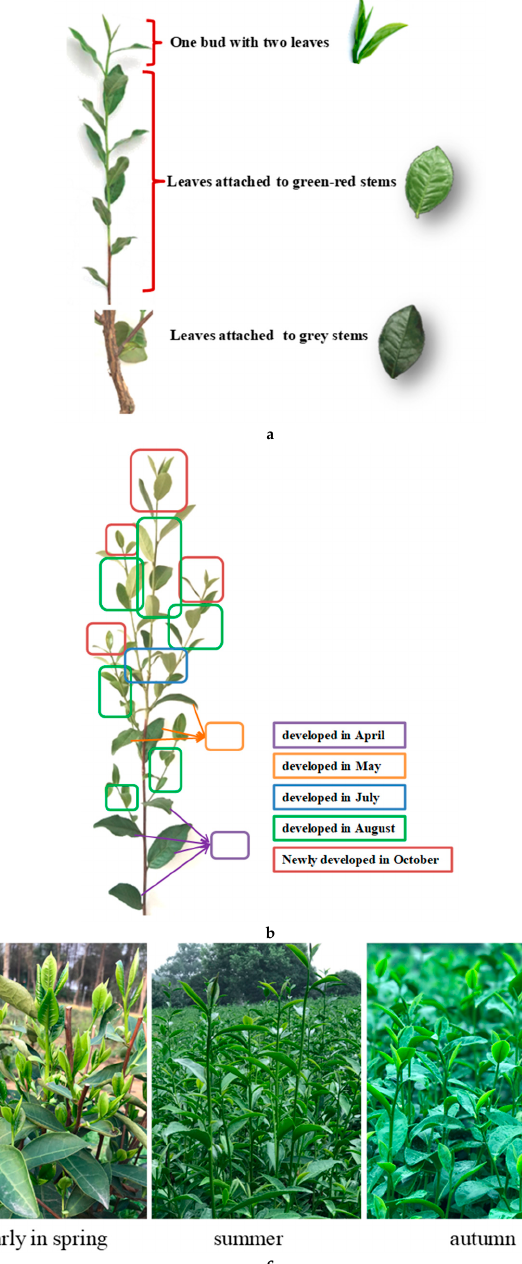
Figure A1. Diagram for tea plant sample standard ( a ); seasonal development of leaves on the tea plant phyllotaxy ( b ); growth performance in a tea garden over the entire season: early spring, summer, and autumn ( c ).